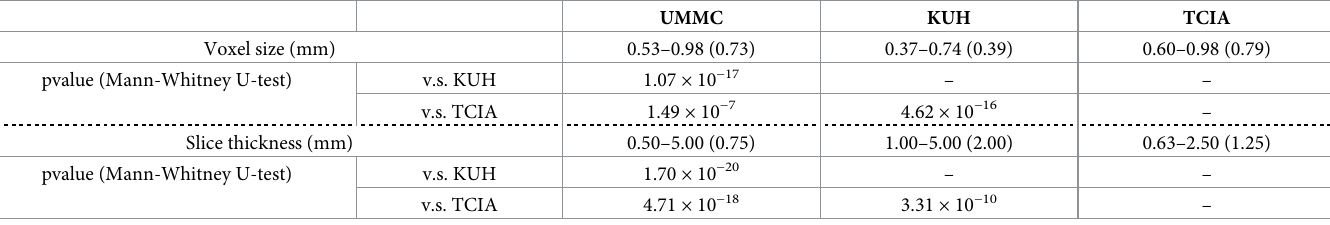
Table 3. Comparison of voxel sizes and slice thicknesses in datasets obtained from University of Malaya Medical Centre (UMMC), Kyushu University Hospital (KUH) and The Cancer Imaging Archive